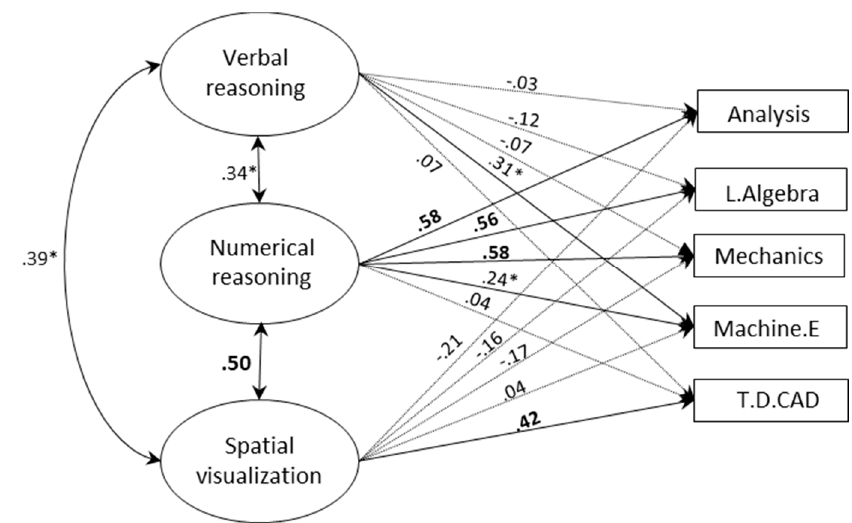
Figure 2 . A SEM with three correlated factors for predicting grades among engineering students ( N = 150). Bolded values indicate p < 0.001; * p < 0.05.